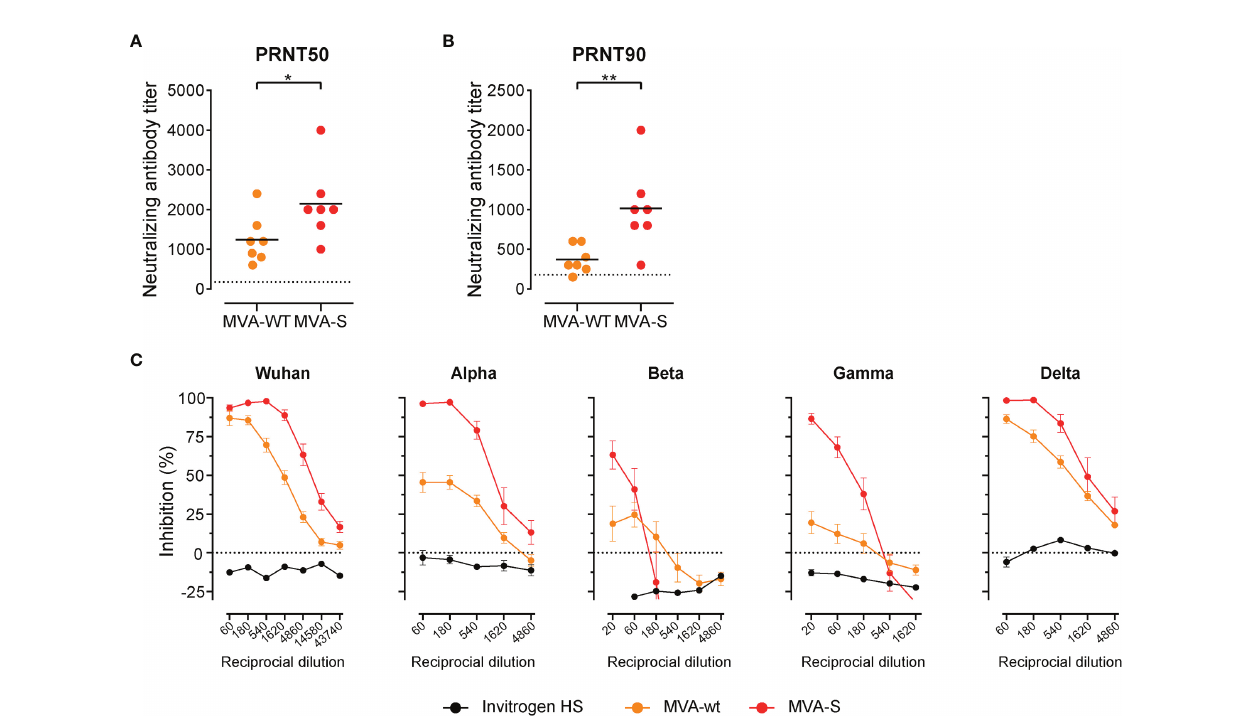
FIGURE 7 | High titer of neutralizing antibodies in serum of immunized hamsters. (A, B) Levels of neutralizing Spike-speci fi c antibodies in serum of hamsters immunized with MVA-WT or MVA-SARS-CoV-2 and measured using SARS-CoV-2 plaque reduction neutralization test (PRNT). Reciprocal titer values that result in 50% (A) or 90% (B) reduction in virus infectivity determined on serially diluted serum of indicated groups 20 days post boost (d46) and 6 days post SARS-CoV-2 infection. (C) Neutralizing antibodies against different SARS-CoV-2-S variants measured by surrogate virus neutralization test (sVNT). Inhibition of binding interaction of SARS-CoV-2 spike-RBD with ACE2 by addition of sera of non-immunized and uninfected hamsters (Invitrogen HS), MVA-WT, and MVA-SARS-CoV-2-S immunized and SARS-CoV-2 infected hamsters. Assay performed in duplicate for each sample; mean percentages of neutralization per group ± SD are shown. (A – C) Pooled data from 2-4 experiments with n = 7 per group. Individual values (signs) and mean group value (line). Statistical analysis was done using Mann- Whitney t test. *p < 0.05, **p <